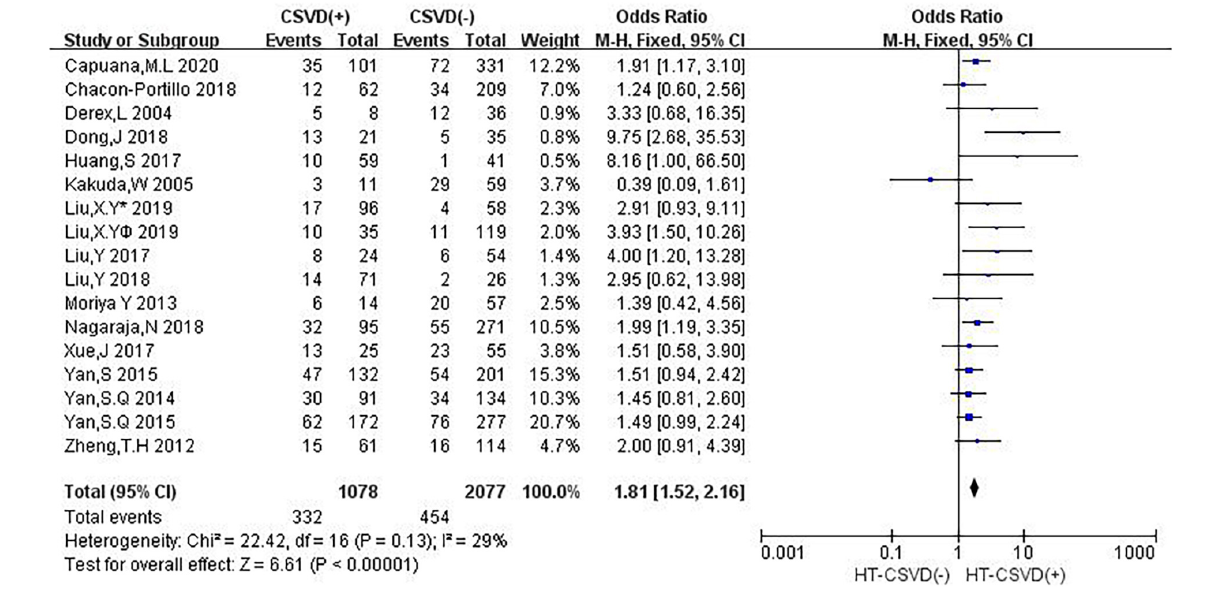
FIGURE 2 | Forest plot showing the Impact of CSVD on HT (Liu, XY v 2019 and Liu, XY R (cid:13) 2019 are from Liu et al. (2019a); Liu, XY ¥ 2019 represents the data of LI in this study, and Liu, Y ∗ 2019 represents the data of CMB in this